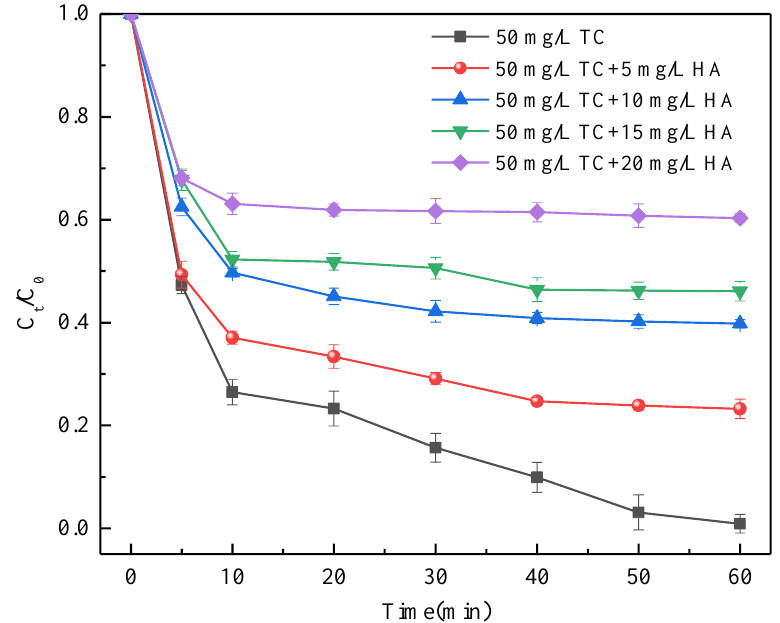
Figure 9. TC removal in the presence of TC and HA. C 0 (mg/L) and C t (mg/L) are the TC concentrations at the initial time and at time t , respectively. Conditions: C 0 = 50 mg/L; [HA] = 5, 10, 15, 20 mg/L; CMC-FeS dosage = 15 mg/L; CMC-to-FeS mass ratio = 1:2; initial pH = 7.0; thermostatic oscillator (150 rpm, 25 ± 1 °C ).